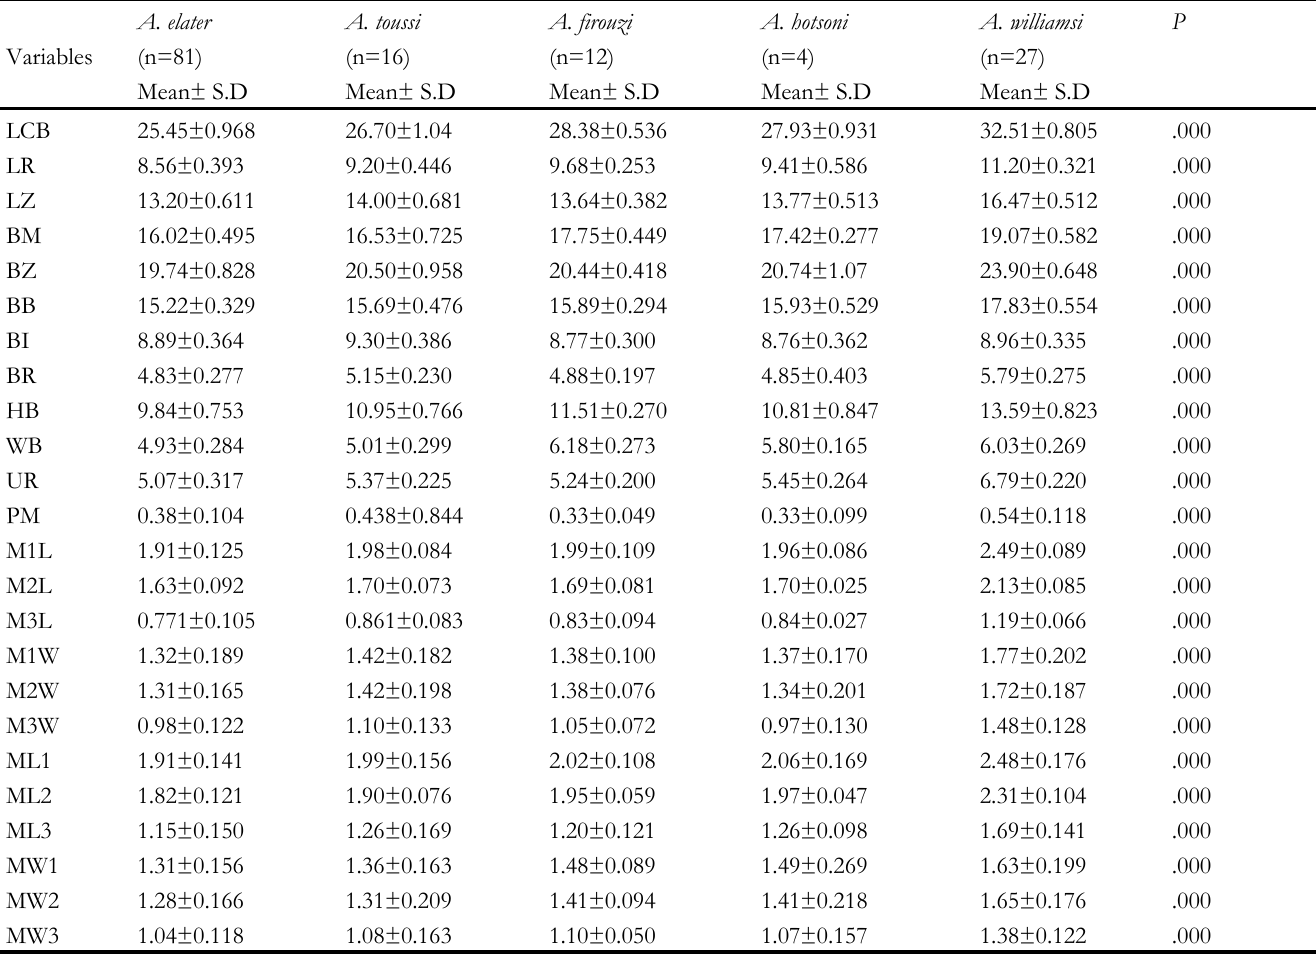
T ABLE 4. Comparison of 24 morphometric variables among all species of Allactaga using ANOVA means with standard error (SE) and